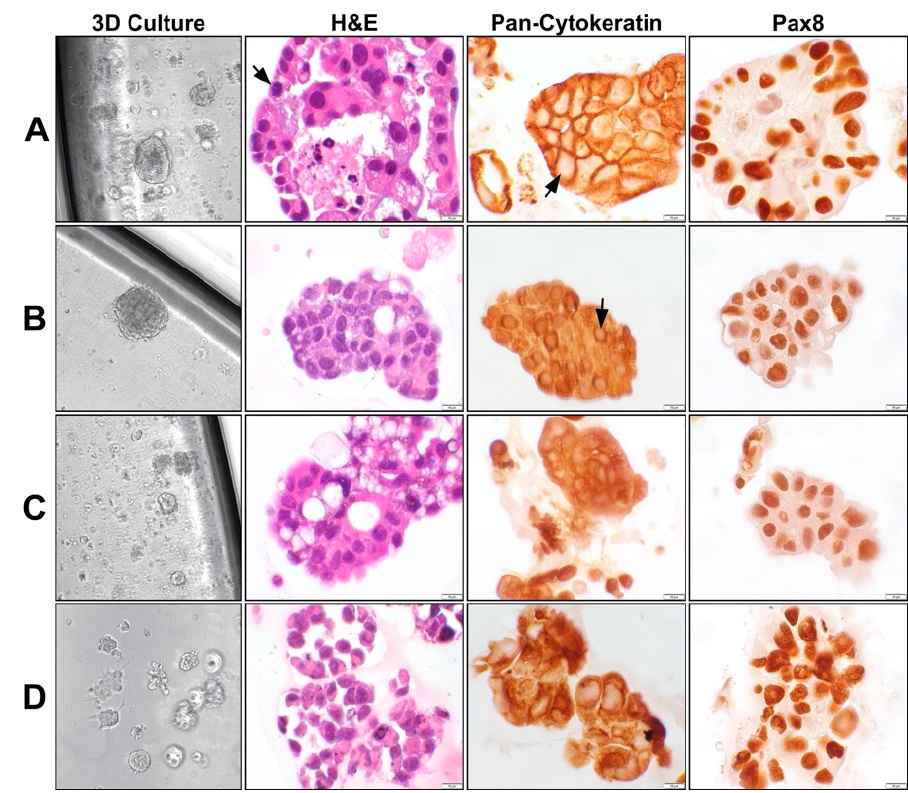
Figure 3. Morphology of platinum-resistant organoids in culture and their respective histology. ( A – C ) Organoids from three independent patients with platinum resistant high-grade serous carcinomas. ( D ) Organoids derived from platinum resistant ovarian cancer cell line OVCAR8. All four organoid models were established in Matrigel-based adherent 3D cell culture. Hematoxylin and eosin (H&E) staining show clusters of malignant cells with pleomorphic nuclei, mitoses (arrow), and necrosis (in A panel). Pan-cytokeratin staining show positivity in the narrow rims of the cytoplasm surrounding the pale staining nuclei (arrow), confirming epithelial origin of the cells. Pax8 shows nuclear staining of the malignant cells, consistent with Mullerian origin of the tumors. The morphological features and the immunohistochemical reactions are remarkably similar in all organoid cultures. All 3D culture organoid pictures are taken with a 20 × objective. All microscopic pictures are taken with a 60 × objective.